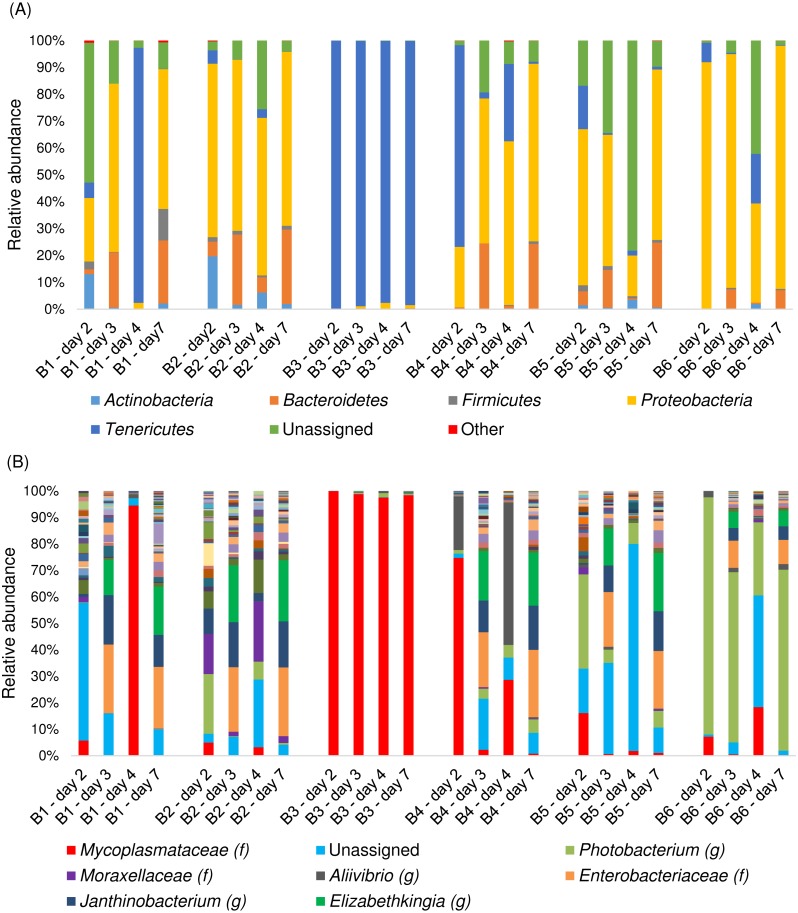
Composition of the bacterial community in samples from the abdominal cavity.Composition of the bacterial community at (A) phylum and (B) genus level. The six groups of columns represent the four sampling days from storage boxes no. 1–6. Each column is a pooled sample from the 2–3 salmon in each storage box. f, family, g, genus.